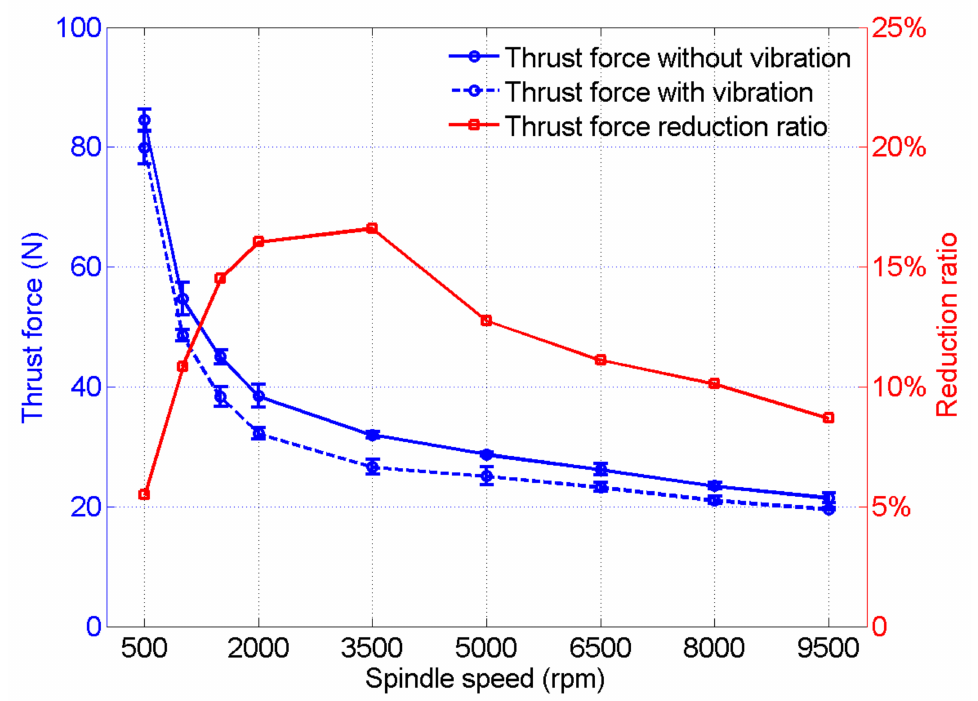
Figure 3. Thrust force comparison between UVD and